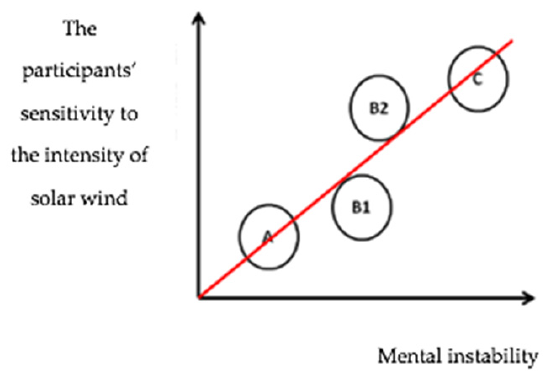
Figure 1. The relationship between the respondents’ mental sensitivity and the intensity of solar activity [9].